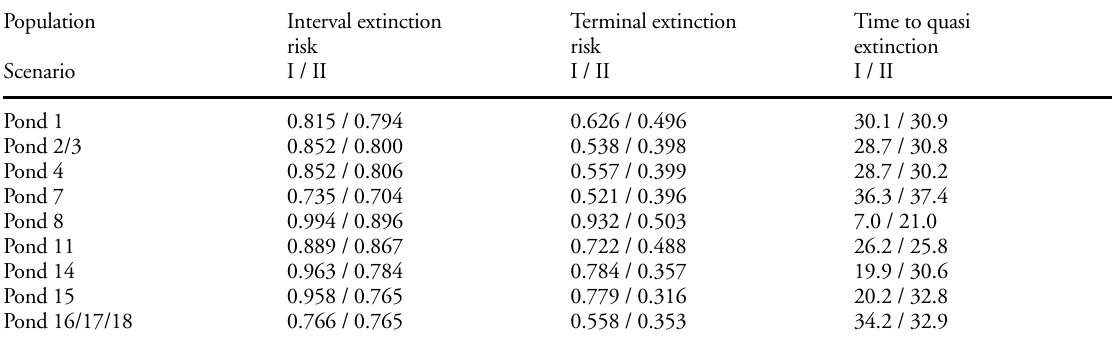
Table 3. Extinction risks for the local populations in the study area under two different scenarios I: no management, and II: with restoration of three ponds and increased pond density. Extinction risk is expressed as the probability of a quasi-extinction in the population (population size falling below 10 females [adults + juveniles]) at least once during 50 years (interval extinction risk); the probability that the population will end up quasi-extinct after 50 years (terminal extinction risk); the median time to quasi-extinction in the population in years (time to quasi-extinction).